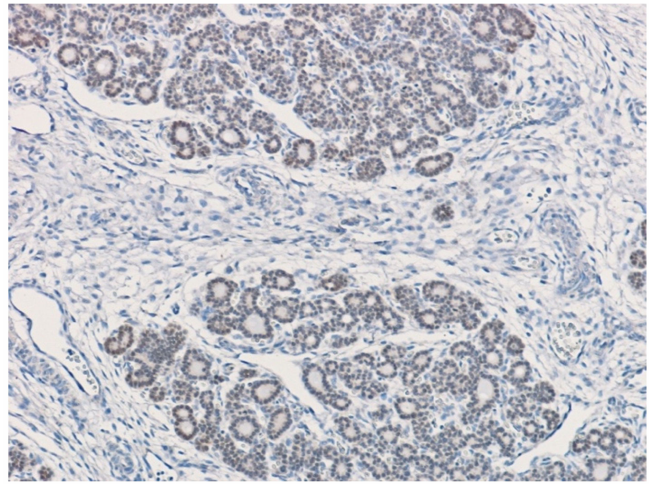
Figure 3. TITF1-positive nuclei (brown) of normal thyroid epithelium of a fetus at 14th week of gestation.